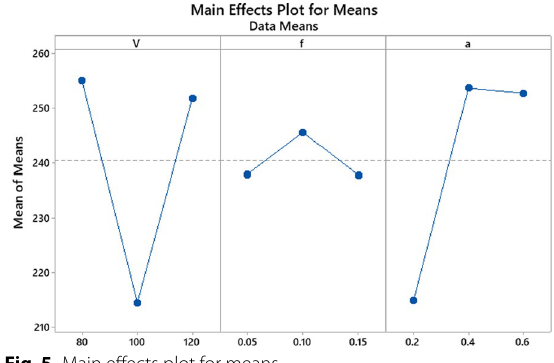
Fig. 5 Main effects plot for means